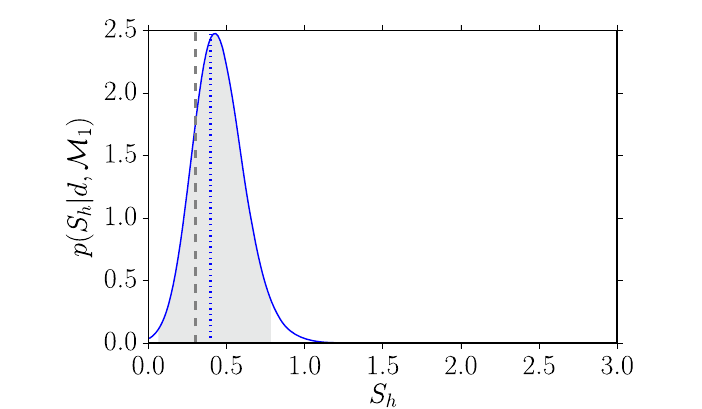
Fig. 18 Marginalized posterior distribution for the stochastic signal variance S h for the signal-plus-noise model M 1 . The actual value of S h used for the simulation is shown by the grey dashed vertical line . The 95% Bayesian credible interval centered on the mode of the distribution is the grey-shaded region . For comparison, the frequentist maximum-likelihood estimator of S h is shown by the blue dotted vertical line